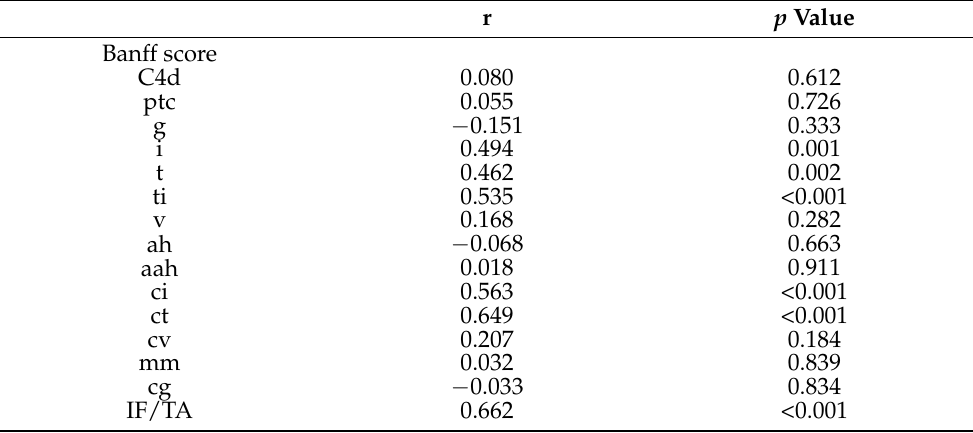
Table 4. Correlations between renal cortical stiffness and histological findings.